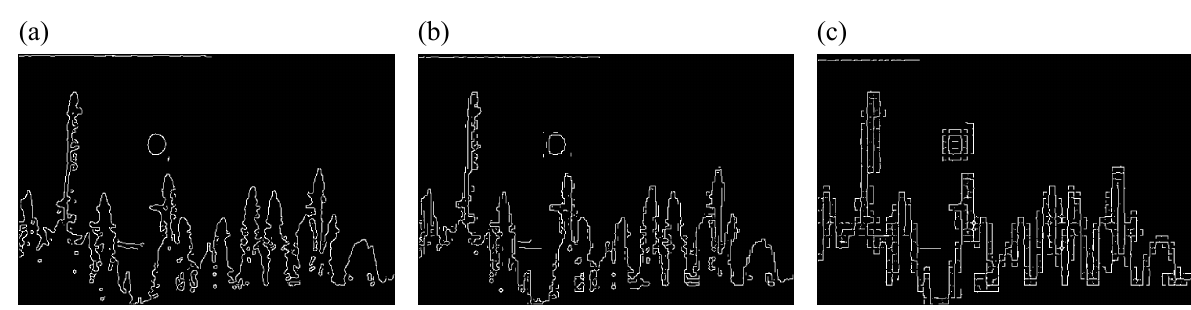
Fig. 9. The example of an image with LD where the Canny edge detection operator was applied to three levels of decomposition for the Haar wavelet transformation. (a) Level 1, (b) Level 2, (c) Level 3.